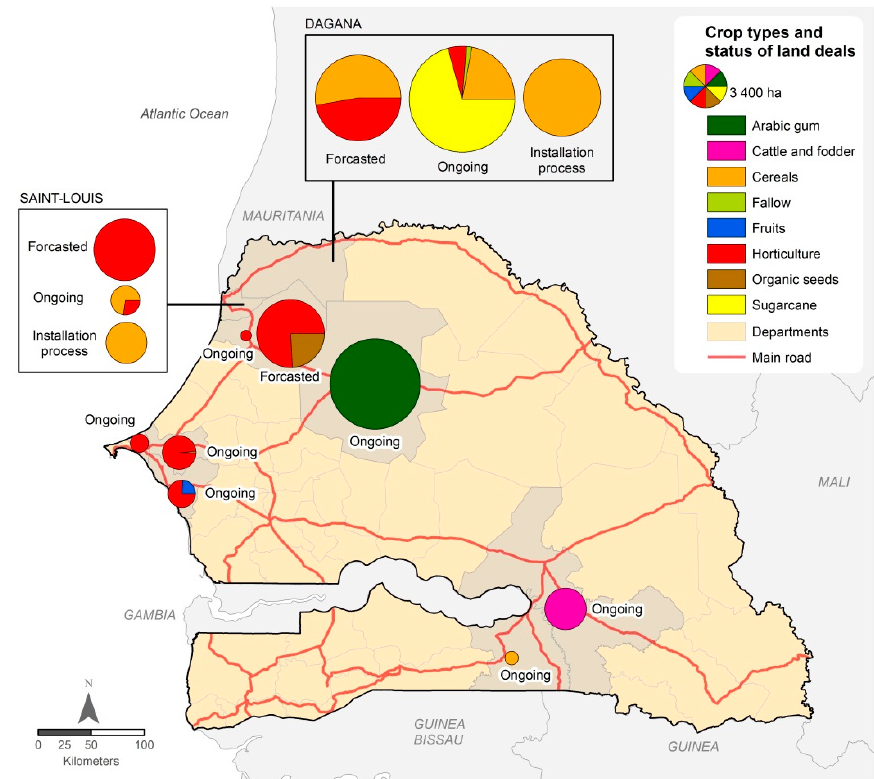
Figure 5. Location and diversity of crops under different status of land transactions.